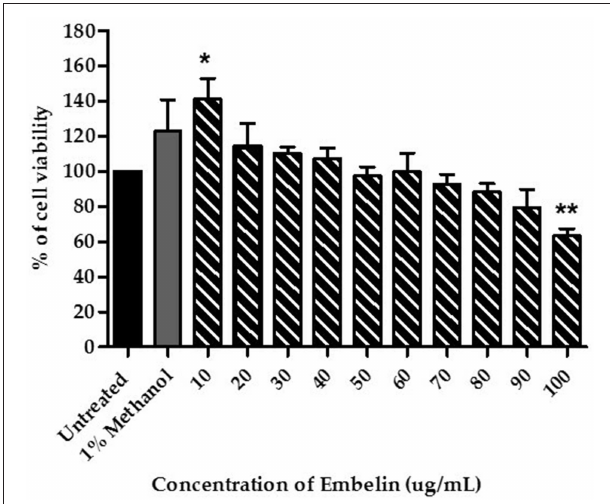
FIGURE 1 | Cytotoxicity of embelin toward primary porcine brain endothelial cells (PBECs), tested using the MTT assay. Untreated cells were used as a control to represent total viable cells. The cells were also treated with 1% (v/v) methanol in culture medium as vehicle control. Data are mean ± SD from 3 independent experiments (n = 3) with 3 replicates for each experiment. * P < 0.05 ** P < 0.01, as tested using One-way